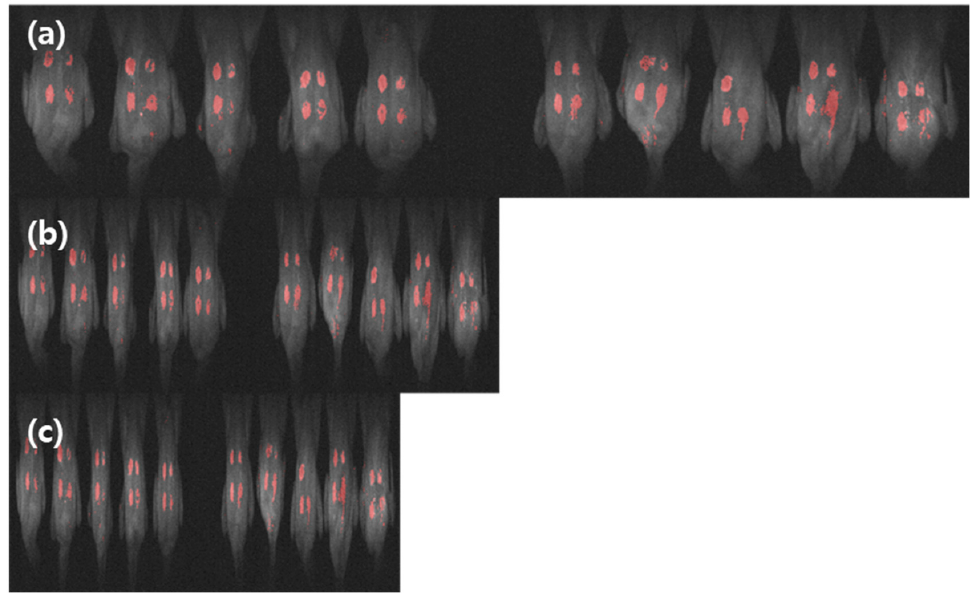
Figure 12. Evaluation of principal component analysis (PCA) for fecal contamination detection on chicken carcasses moving at three different speeds of conveyor line: ( a ) 1 bird/s, ( b ) 3 birds/s, and ( c ) 5 birds/s. PCA detection and isolation accuracy for fecal spots on chicken carcasses is 97.5%.